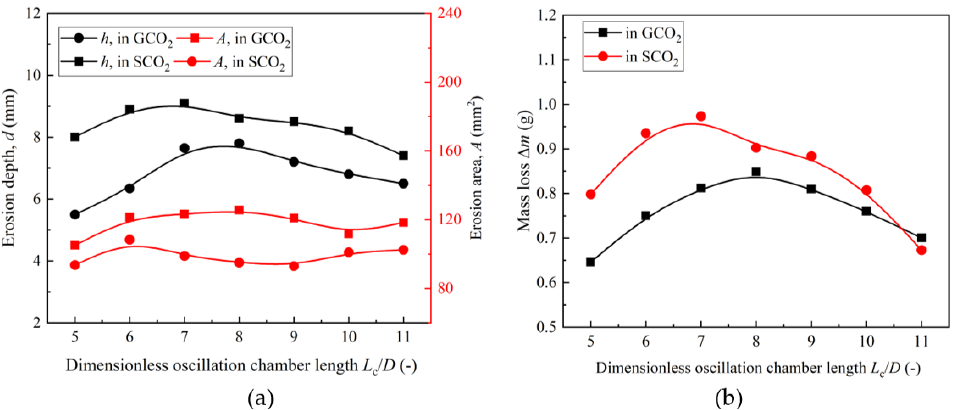
Figure 12. ( a ) the variation in erosion depth and erosion area with the oscillation chamber length, and ( b ) the variation in mass loss with the oscillation chamber length. Experimental conditions: ∆ P = 10 MPa, 5 ≤ L c / D ≤ 11, and P a = 6 or 8.5